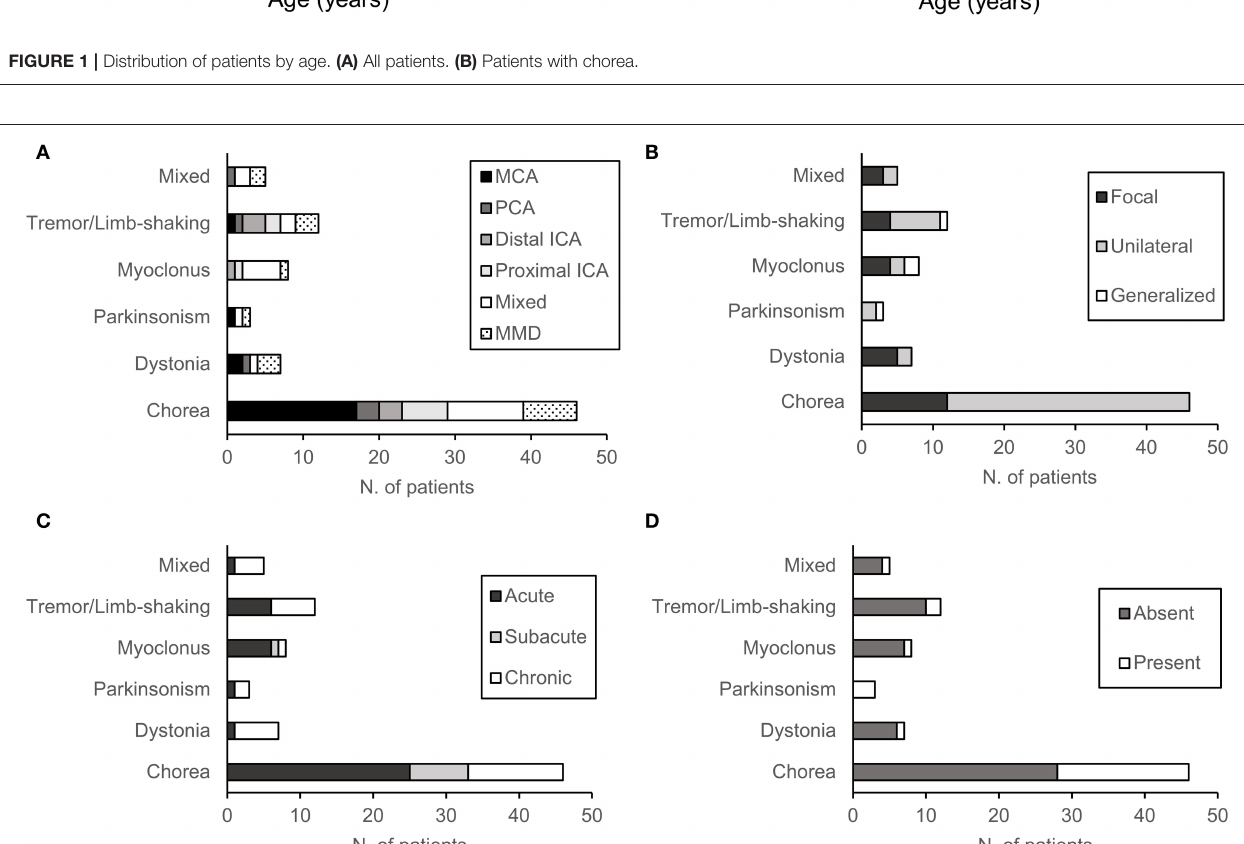
FIGURE 2 | Characteristics of patients according to movement disorder phenotype: (A) Location and etiology of cerebral arterial stenosis (CAS), (B) mode of onset, (C) distribution of symptoms, and (D) the presence of acute stroke lesion.